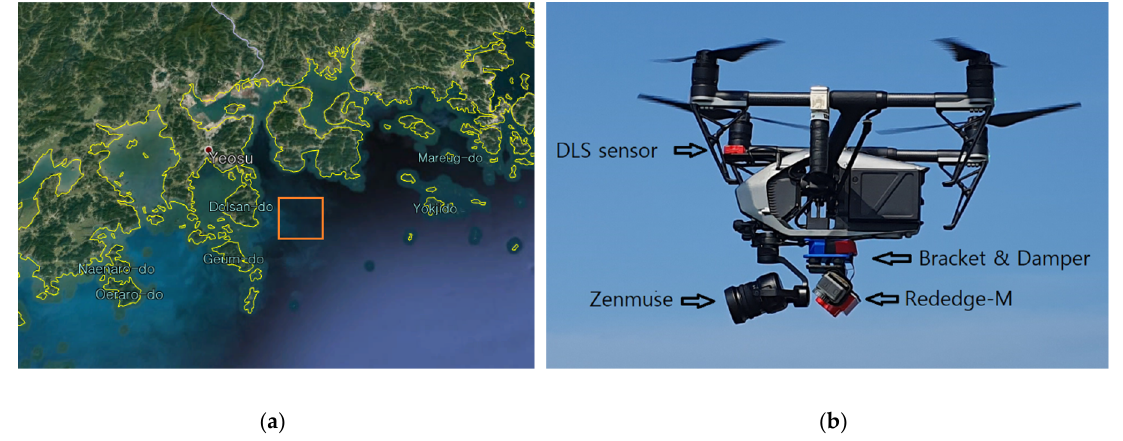
Figure 2. ( a ) Lens configuration of Rededge-M camera and ( b ) the spectral response function of the bands overlaid with a typical vegetation spectrum (source: Rededge-M User Manual).